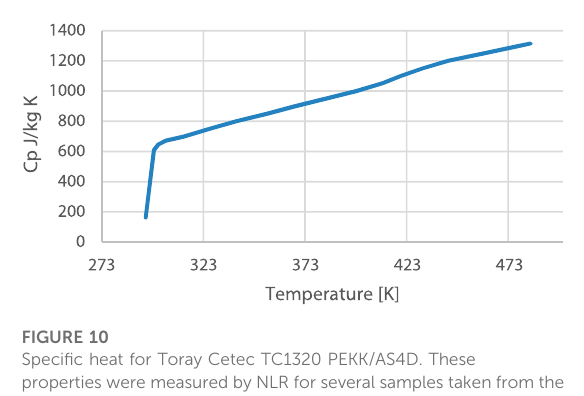
FIGURE 10 Speci fi c heat for Toray Cetec TC1320 PEKK/AS4D. These properties were measured by NLR for several samples taken from the composite plates manufactured for this study. The average value of the measurements of the samples was